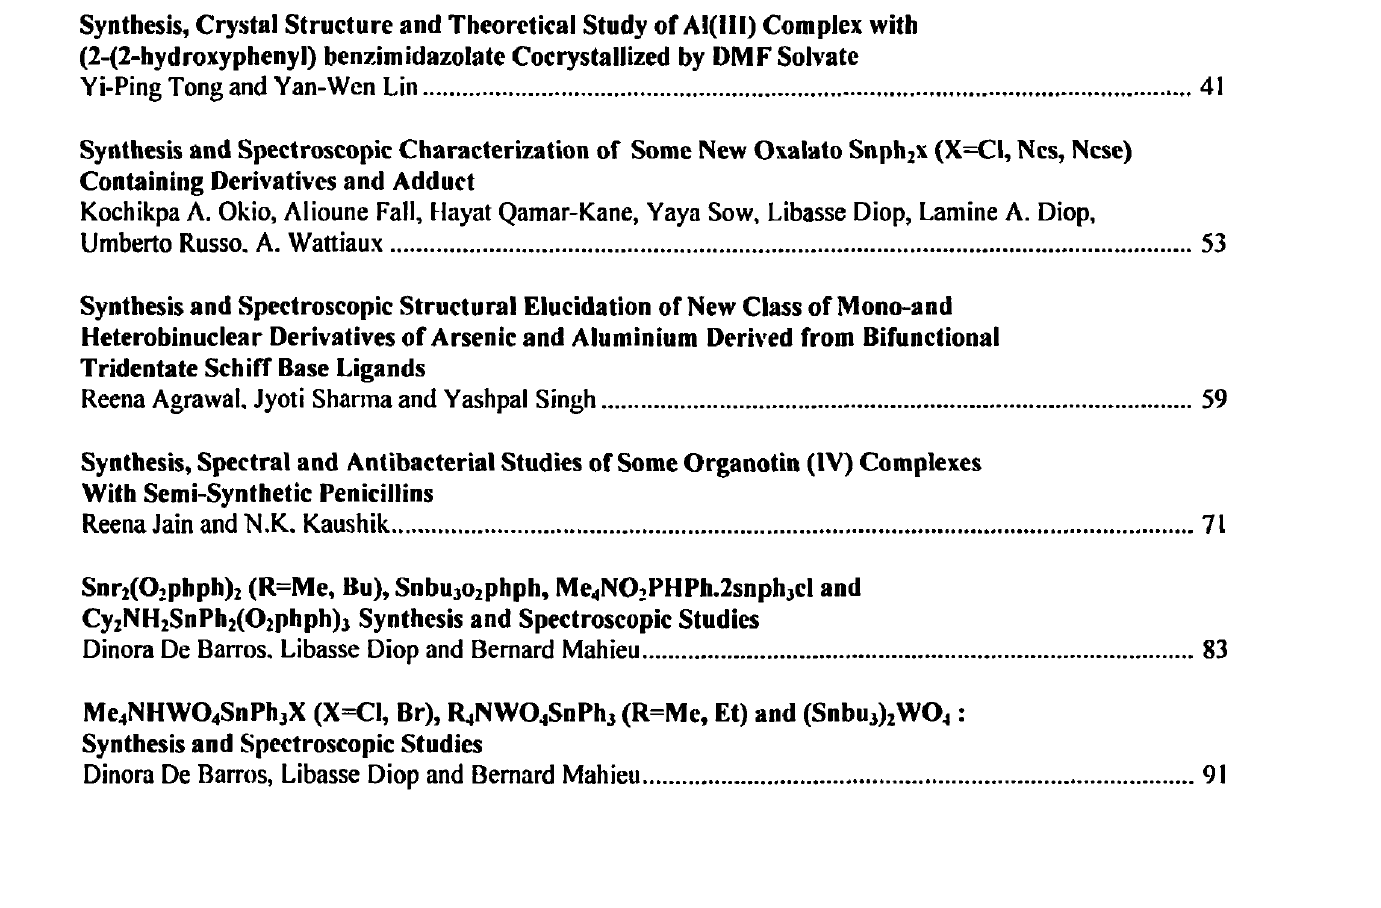
Synthesis, Spectral and Antimicrobial Studies of Mixed-ligand Complexes of Antimony (III) with |3(2'-hydroxyphenyI)-5-(4-substituted phenyl) pyrazolinesj and 2-(N-salicylidine)-5- Chlorobenzophenone